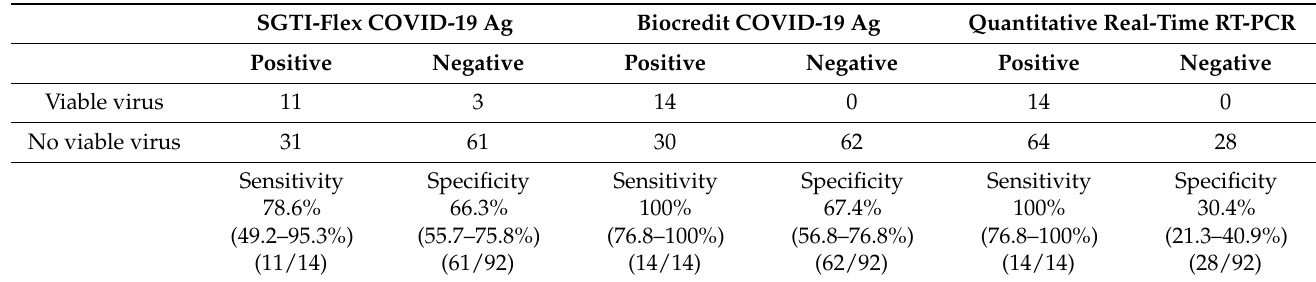
Table 4. Assessment of sensitivity and specificity of rapid tests for